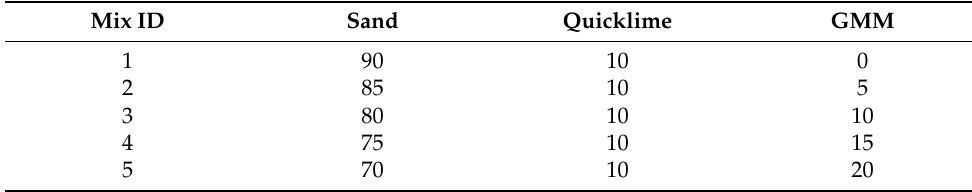
Figure 2. Flowchart for obtaining samples of silicate bricks. Table 4. Compositions of pressed